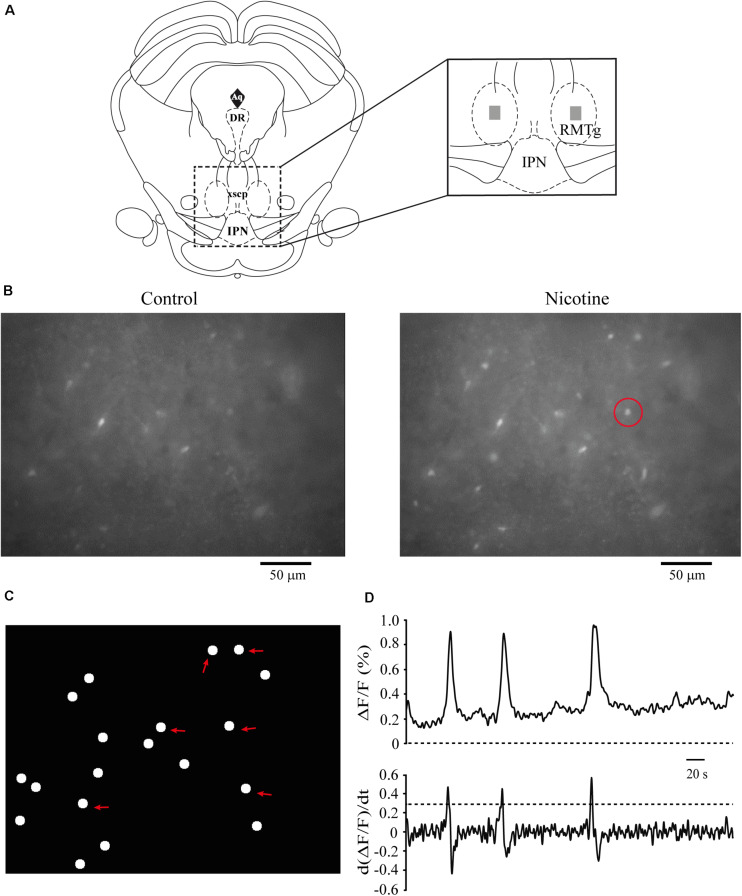
Calcium imaging recordings. (A) Schematic representation of a coronal slice containing the RMTg area. The zone within the square was amplified (right). The dark gray rectangles indicate the region within the RMTg where calcium image recordings were made. (B) Raw data of calcium imaging recordings in control conditions (left) and nicotine (1 μM, right). Each image was obtained from a single frame of the video. (C) Scheme showing the coordinates map of the active cells constructed from the video (see section “Materials and Methods”). The red arrows indicate the locations of the cells recorded in (B). (D) Calcium transients (top) and their first derivate (bottom), which correspond to the cell encircled in (B) (right, red circle). RMTg, rostromedial tegmental nucleus; IPN, interpeduncular nucleus.